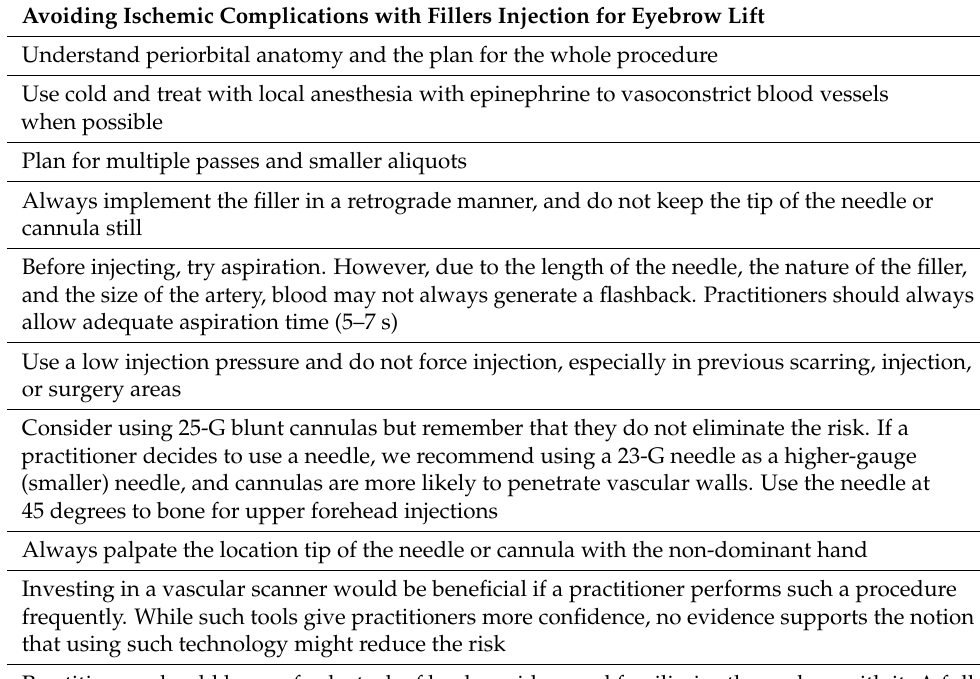
Table 3. Injection techniques to help avoid ischemic